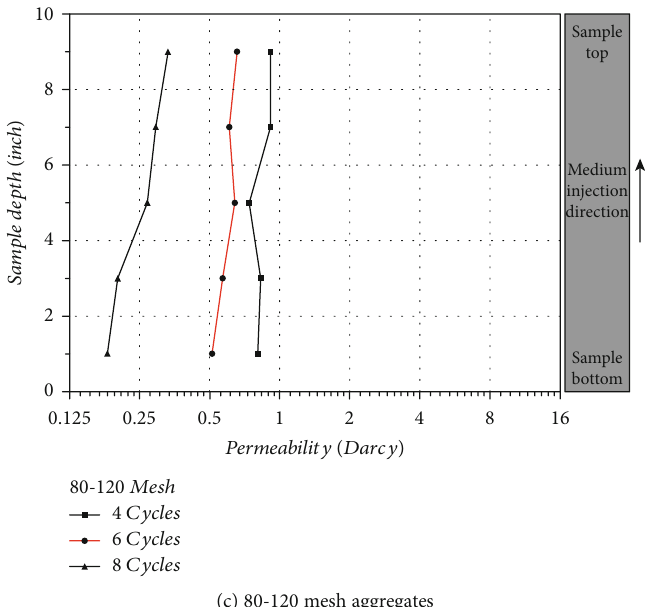
Figure 3: Variation in permeability for the treated arti fi cial cores representing (a) 40-60 mesh aggregates, (b) 60-80 mesh aggregates, and (c) 80-120 mesh aggregates for 4, 6, and 8 cycles of nutrient circulation.